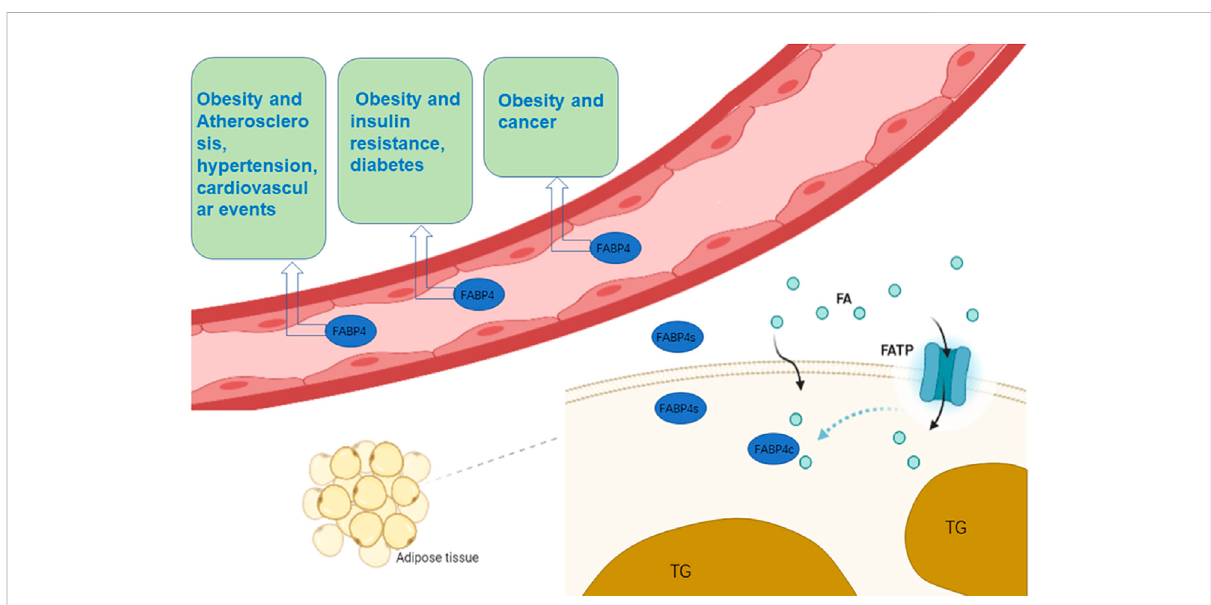
FIGURE 1 TheroleofFABP4incellsandblood.nadipocytes,FABP4bindstoFAsthatenterthecellmembraneandassistintheirtransport.Simultaneously, fat cells synthesize FABP4 and release part of it into the blood. Circulating FABP4 plays an undeniable role on atherosclerosis, hypertension, cardiovascular events, insulin resistance, diabetes and cancer. (Some of the elements in the fi gure come from